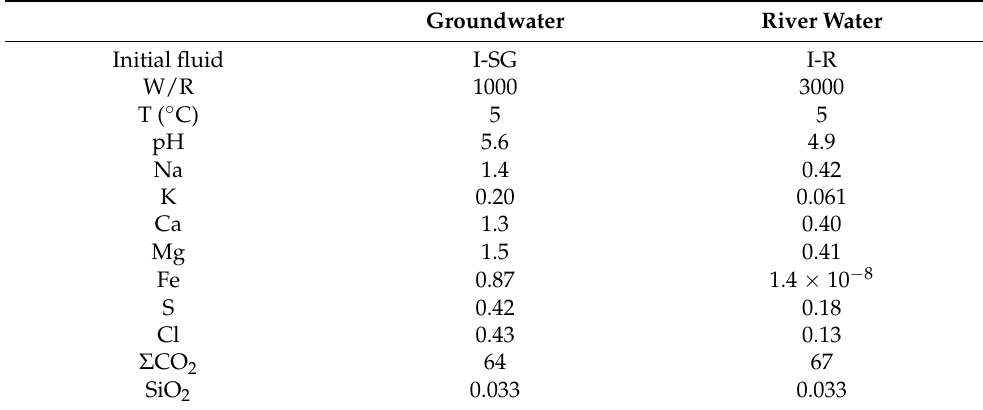
Table 3. Calculated chemical composition of groundwater and river water that assumed to have been present in Gale. The values are calculated by thermodynamic calculations simulating water–rock